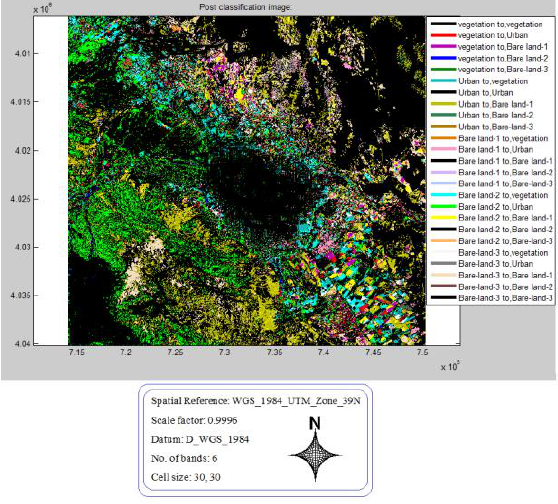
Figure 6. The produced change image map using PCC method